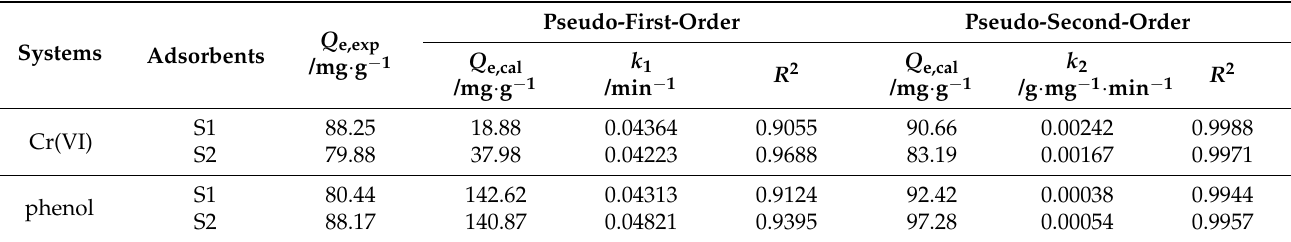
Table 2. This indicated that the adsorption rates of Cr(VI) and phenol onto SiO 2 -g- PBA-b-PDMAEMA were controlled by chemical processes [9]. The rate constant k 2